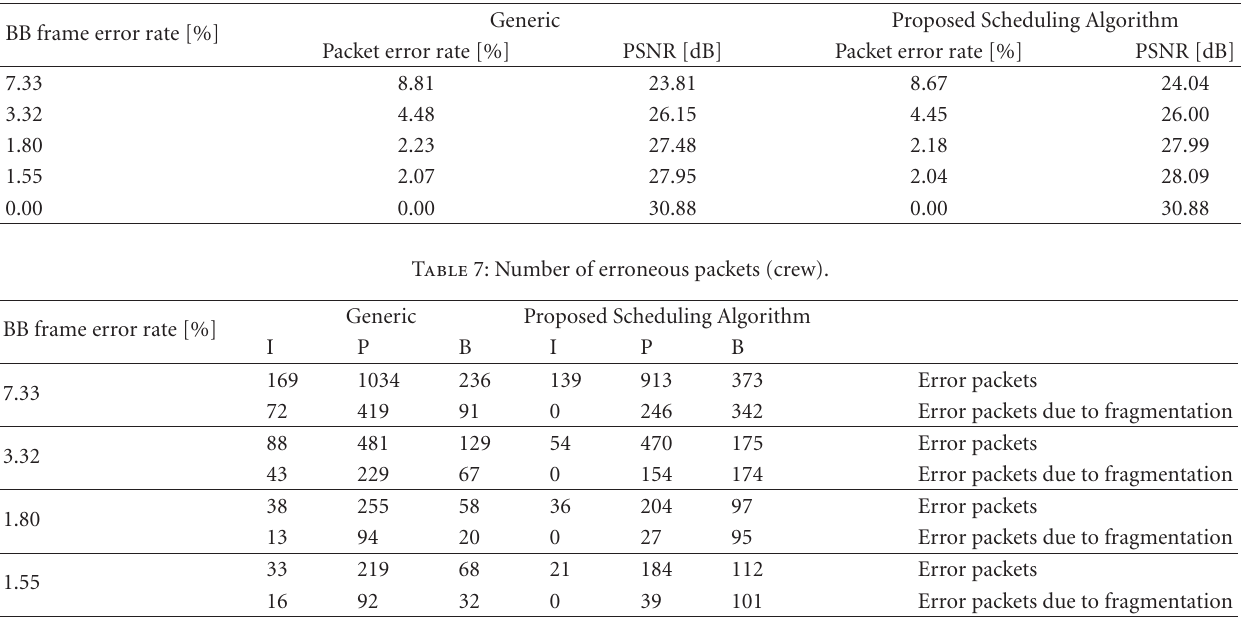
Table 6: PSNR and Packet error rate (crowd).